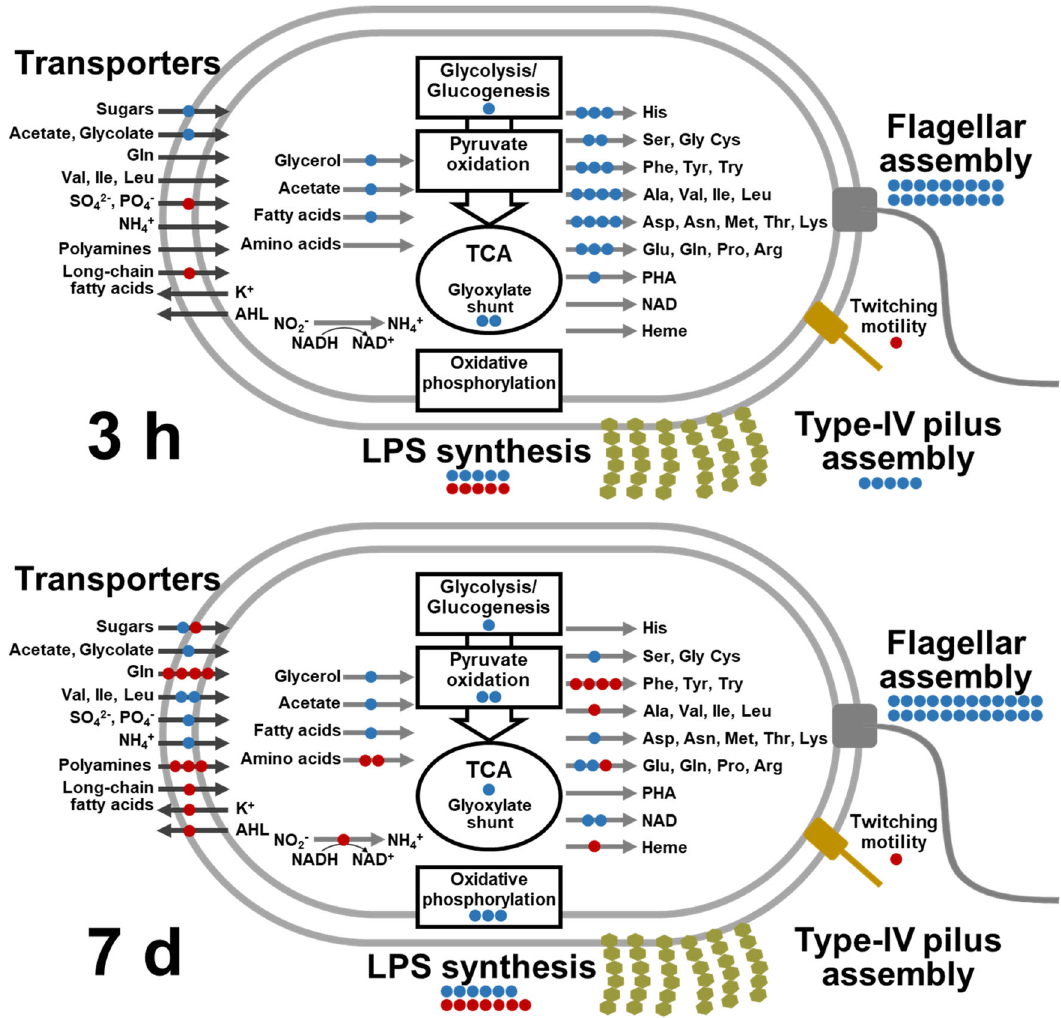
Fig. 3 Important metabolic pathways and cellular components for the ef fi cient duckweed colonization (3 h) and fi tness (7 d) of Aquitalea magnusonii H3. Blue and red circles represent the occurrence of depleted and enriched genes, respectively, in the corresponding pathways or functions. Gene roles were predicted according to the best-matched entry in the KEGG orthology database. Amino acids are denoted by their standard three-letter code. LPS, lipopolysaccharide; PHA, polyhydroxyalkanoate; AHL, acyl-homoserine lactone. Supplementary Data 8 shows the list of depleted and enriched genes in this fi